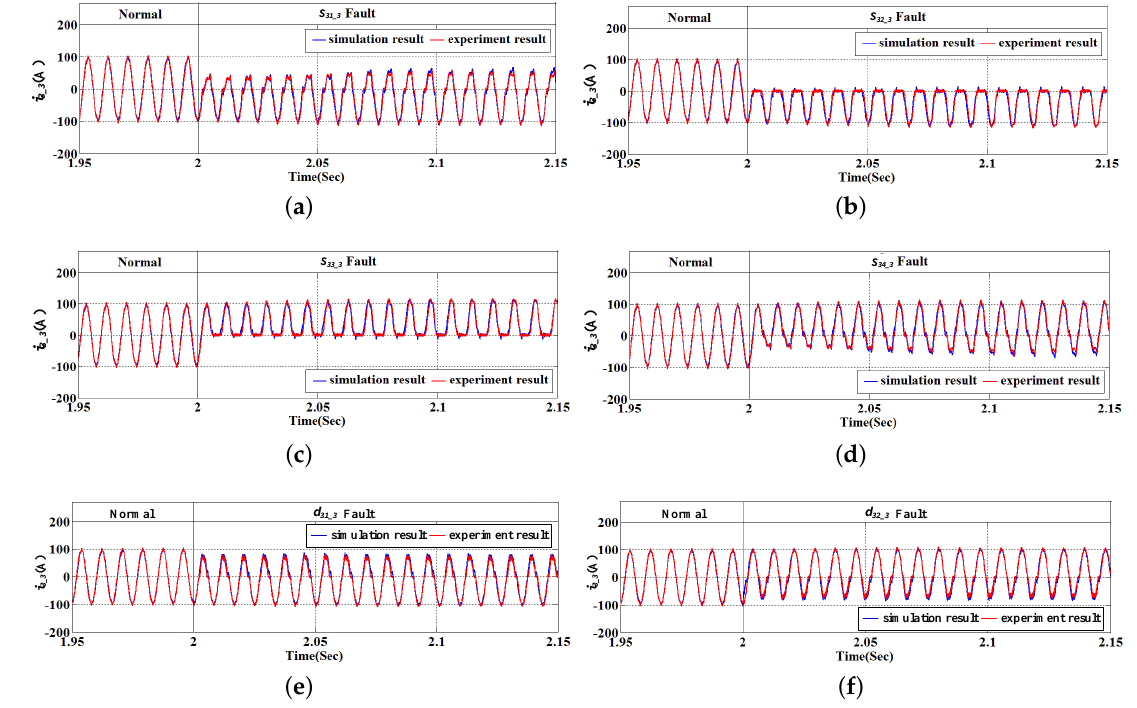
Figure 11. Results of open-circuit faults happening in the third arm.